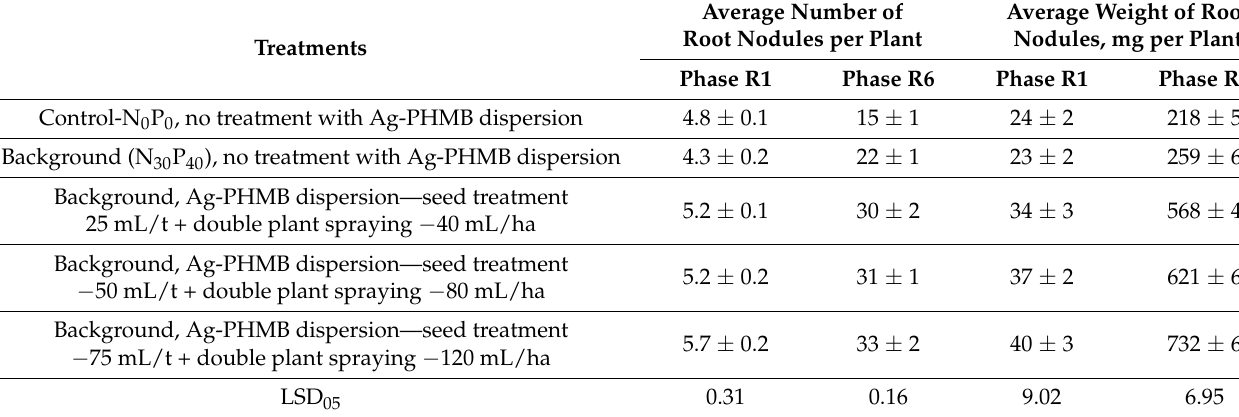
Table 1. Effect of seed and foliar treatments during phases V3 and R1 with aqueous dispersions of silver NPs stabilized with PHMB (Ag-PHMB) on the number and average weight of root nodules (averaged values for 2019–2020), confidence probability, p = 0.95. Average Number of Average Weight of Root Root Nodules per Plant Nodules, mg per Treatments